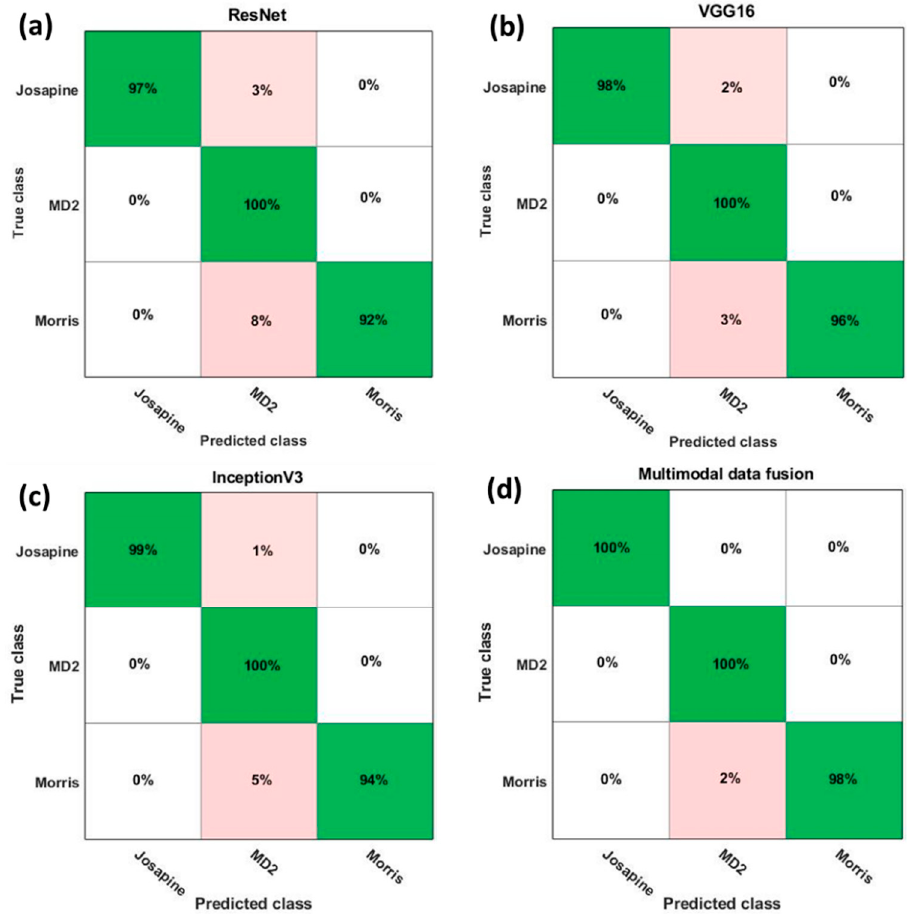
Figure 5. The confusion matrix of deep learning models for ( a ) ResNet, ( b ) VGG16, ( c ) InceptionV3, and ( d ) multimodal data fusion. Table 4. Performance metrics comparison of the deep learning